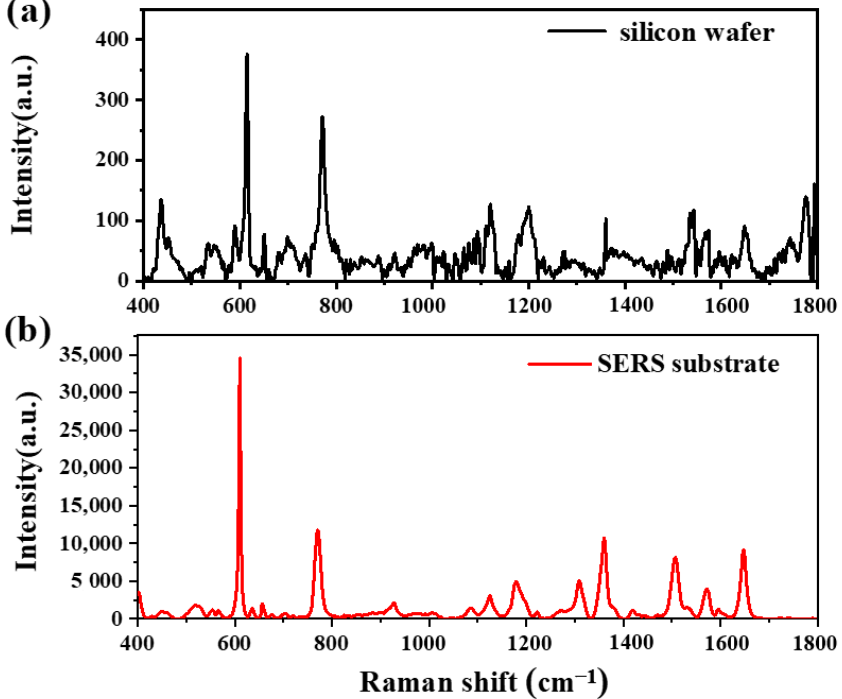
Figure 6. Tested Raman spectra of R6G: ( a ) Silicon wafer and ( b ) SERS substrate.